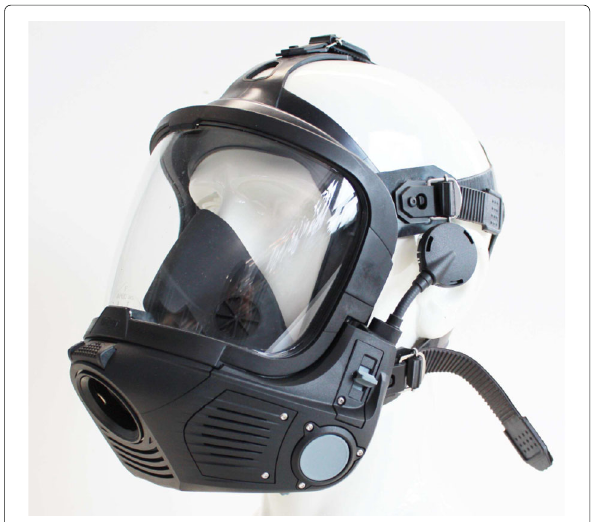
Fig. 3 Full-face mask (FPS 7000, Dräger [3]) with a communication system (FPS-COM 7000, Dräger